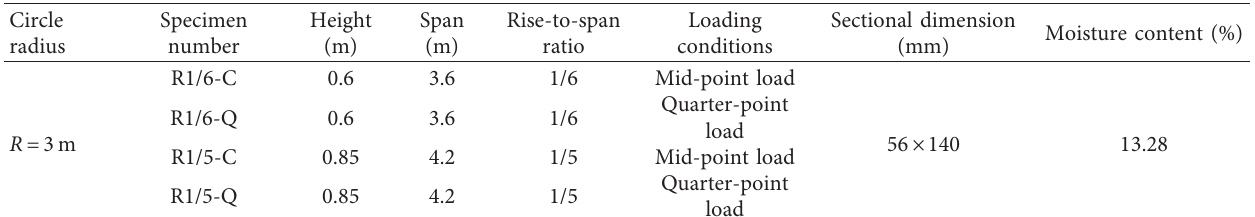
Figure 2: Schematic drawing of specimens (unit: mm): (a) vertical view and (b) cross section. Table 2: Specimen details.